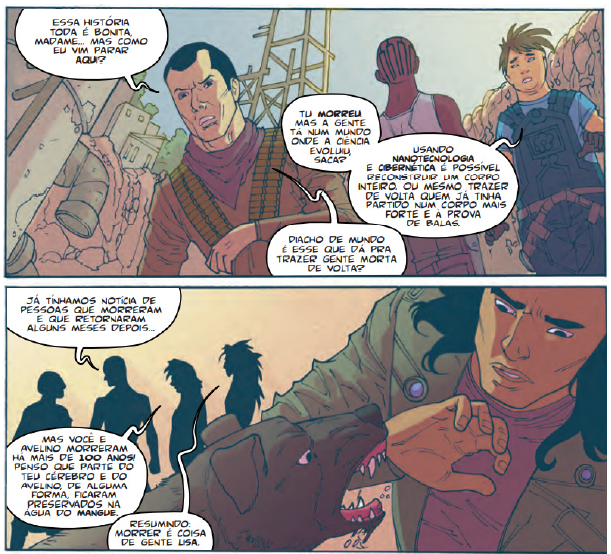
Figure 4. Zé Wellington and Walter Geovani. Cangaço Overdrive (p. 41). Courtesy of the